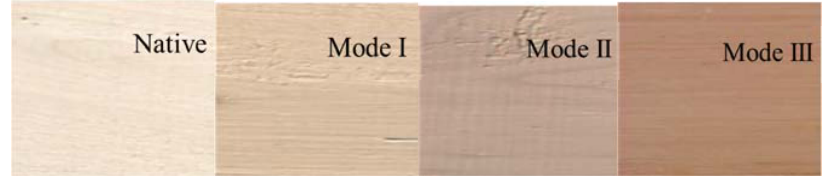
Figure 10. View of birch wood before and after heat treatment by individual modes.